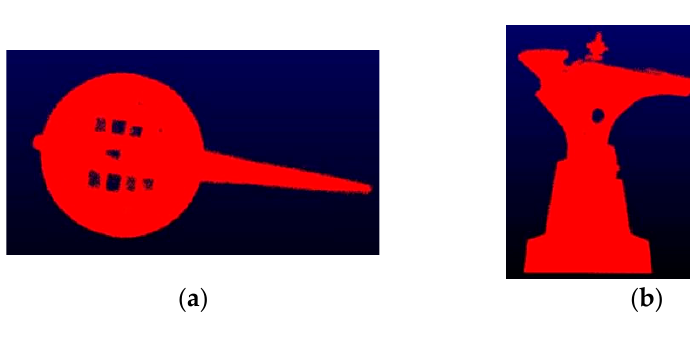
Figure 8. HLS point cloud projection view obtained in different directions. ( a ) Top view. ( b ) Front view. ( c ) Rear view.